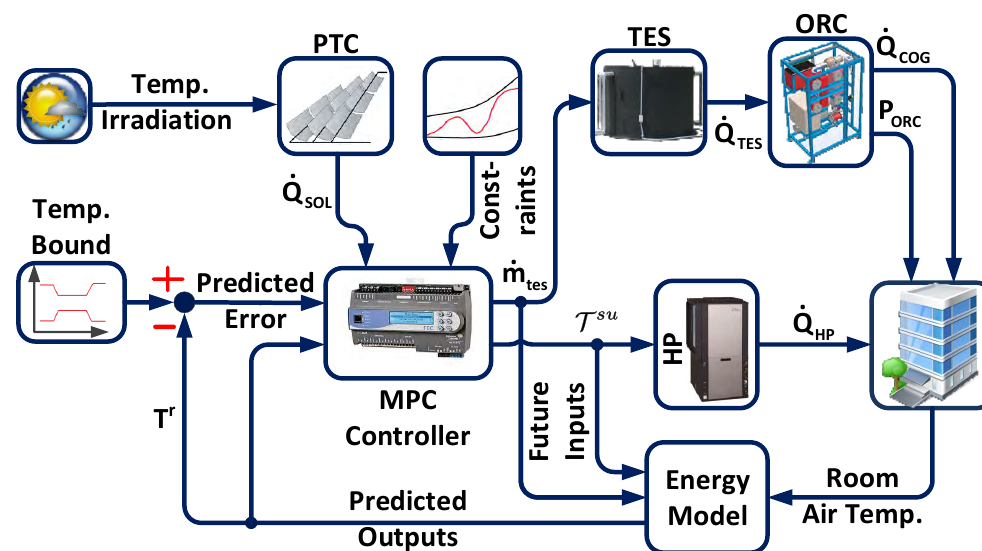
Figure 14. Structure of the energy-based MPC to control MicroCSP and HVAC systems. (Reprinted from [20] with permission of